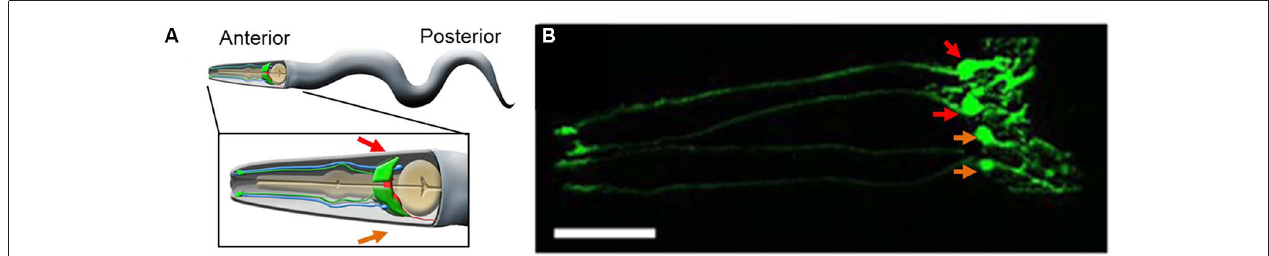
driven by the hlh-17 promoter to visualize the four CEPsh glial cells (worm strain VPR839). The anterior (head) of a juvenile (larval stage 4) worm is shown; the worm is turned ∼ 45 ◦ from “upright” such that all four CEP sheath cells are visible. The sheath portion of the cells that form a tube around the dendritic endings of the CEP neurons are seen at the left of the image. The dorsal (red arrows) and ventral (orange arrows) CEPsh cell bodies are seen. The thin sheet-like extensions that surround and invade the nerve ring are seen in the rightmost part of the image. Scale bar, 20 µ m. Image adapted from Stout et al.